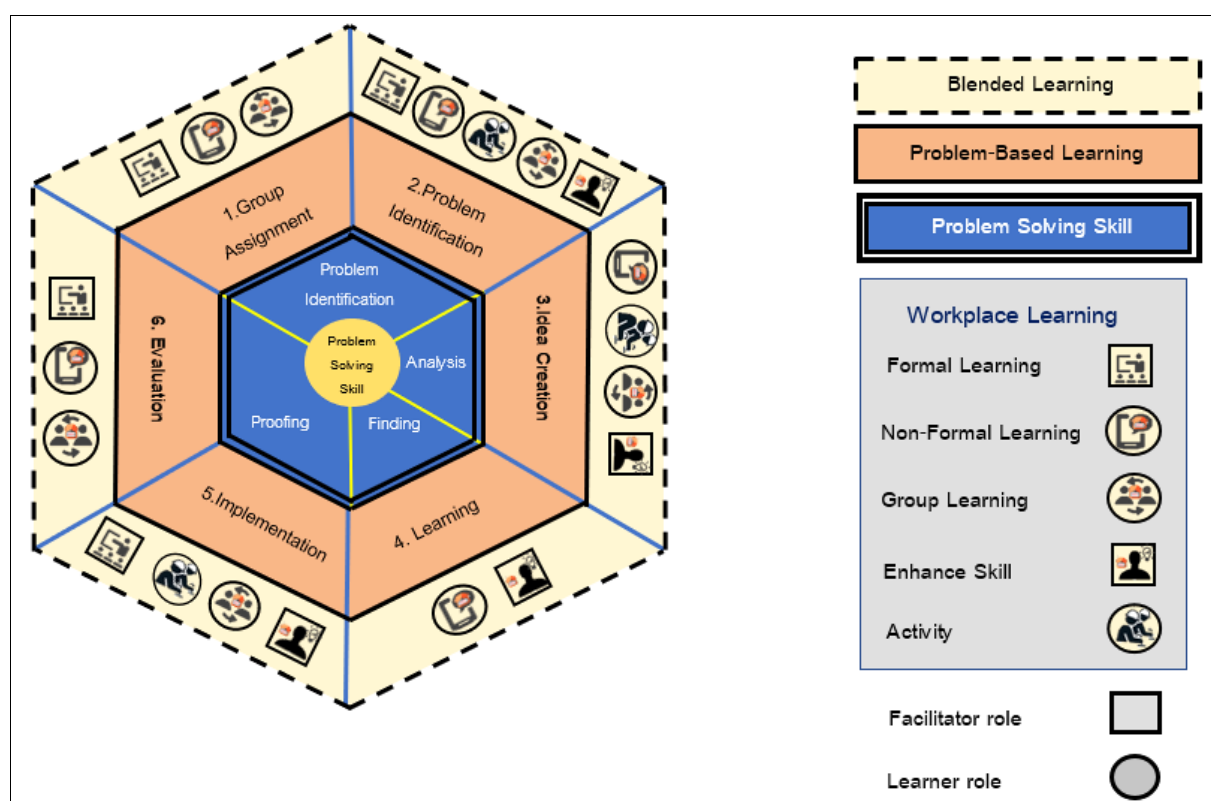
Figure 2. The problem-based blended training model via chatbot to enhance problem-solving skills in the workplace